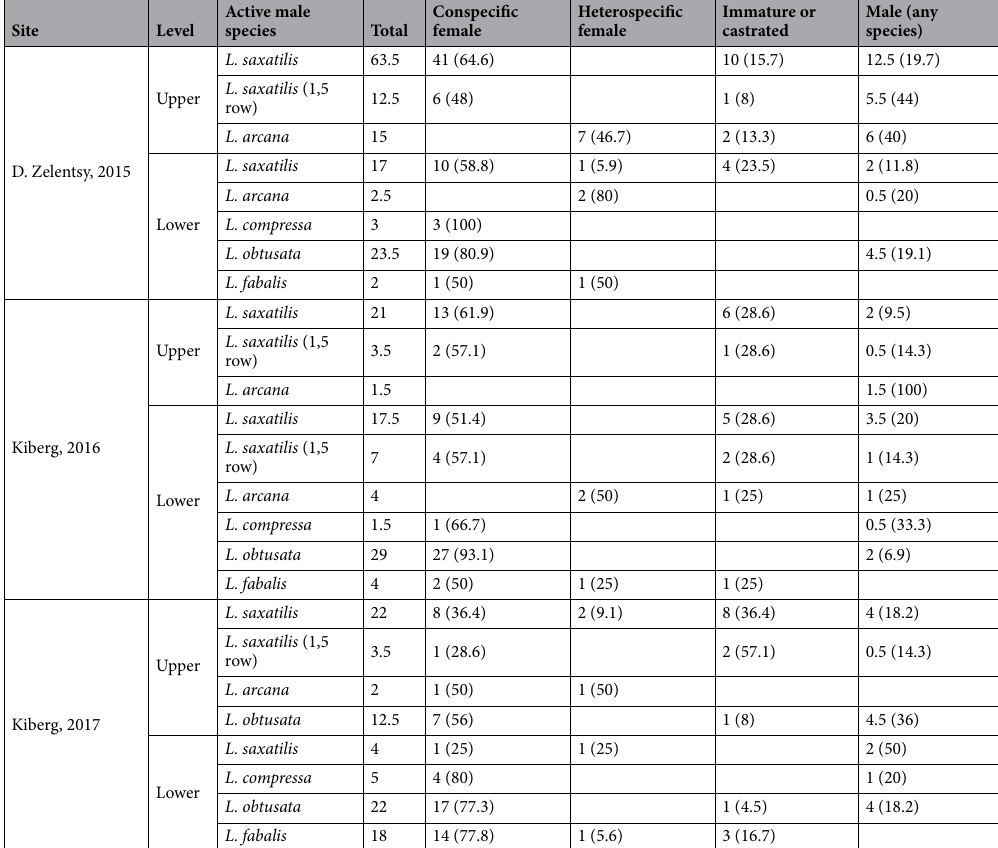
Table 2. Mating patterns of active male Littorina snails grouped by site, intertidal level and species. Total number of copulations of a particular active partner type, as well as the number (and percentage) of copulations grouped by passive partner category is given. Male-male copulations were registered as 0.5 for each of the partners, because it was impossible to determine which of them was active. The category L. saxatilis (1.5 row) includes male L. saxatilis with 1.5 rows of penial glands (presumably hybrids of L. saxatilis and L. arcana ); both L. saxatilis and L. arcana females were considered their conspecifics. Empty table cells indicate that corresponding mating combinations were not